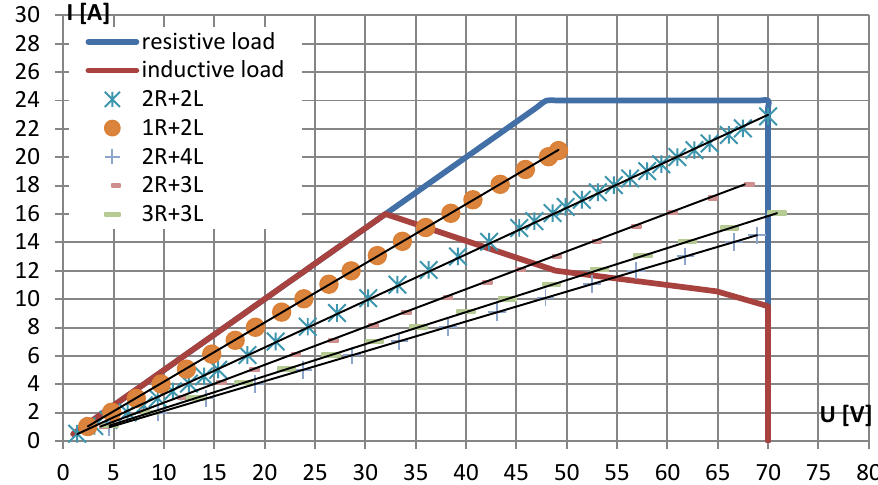
Figure 7. The rms values of the output current vs. output voltage of the audio power amplifier for the combined resistive and inductive loads for single channel operation.